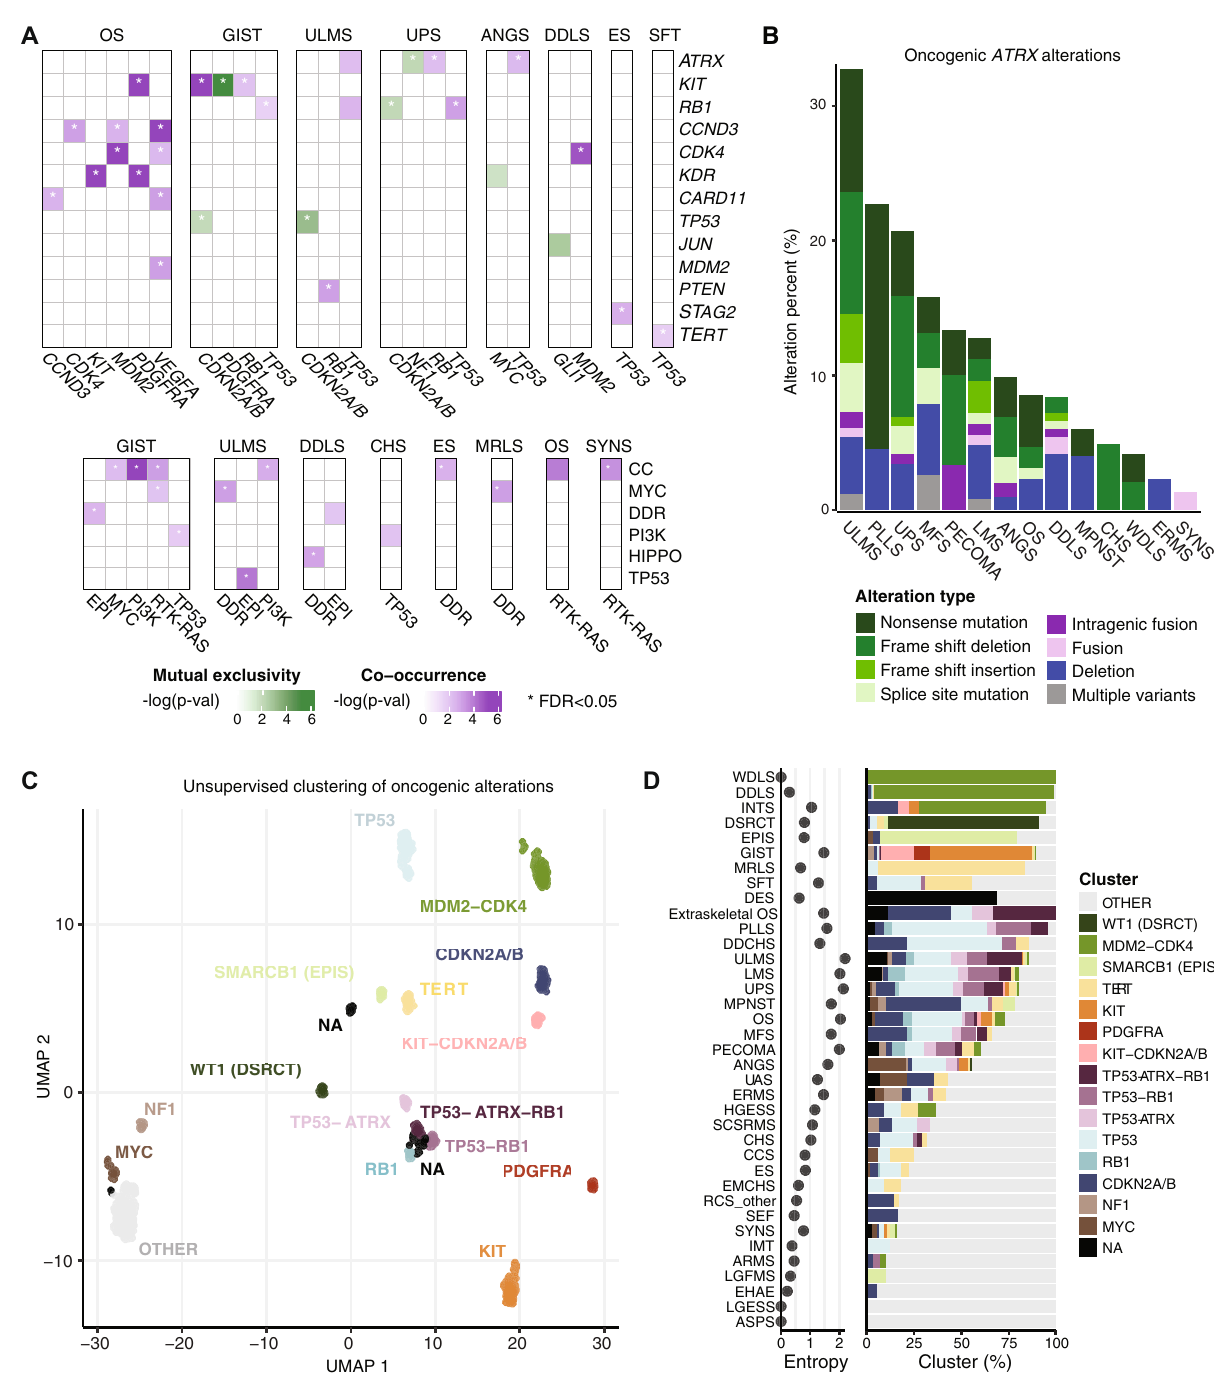
Fig. 5 Mutual exclusivity, co-occurrence, ATRX alterations, and unsupervised clustering based on genetic signatures. A Co-occurrence and mutual exclusivity of gene- (top) and pathway-level (bottom) alterations in each subtype with signi fi cant fi ndings shown. Signi fi cance was evaluated by two-sided Fisher ’ s exact test. EPI, epigenetic; DDR, DNA damage repair. B Frequency and types of oncogenic ATRX alterations in each of the 14 most altered subtypes. C Unsupervised clustering of all samples based on oncogenic alteration patterns. D Subtype-speci fi c cluster associations and entropy scores. For clarity, subtypes with n > 5 are